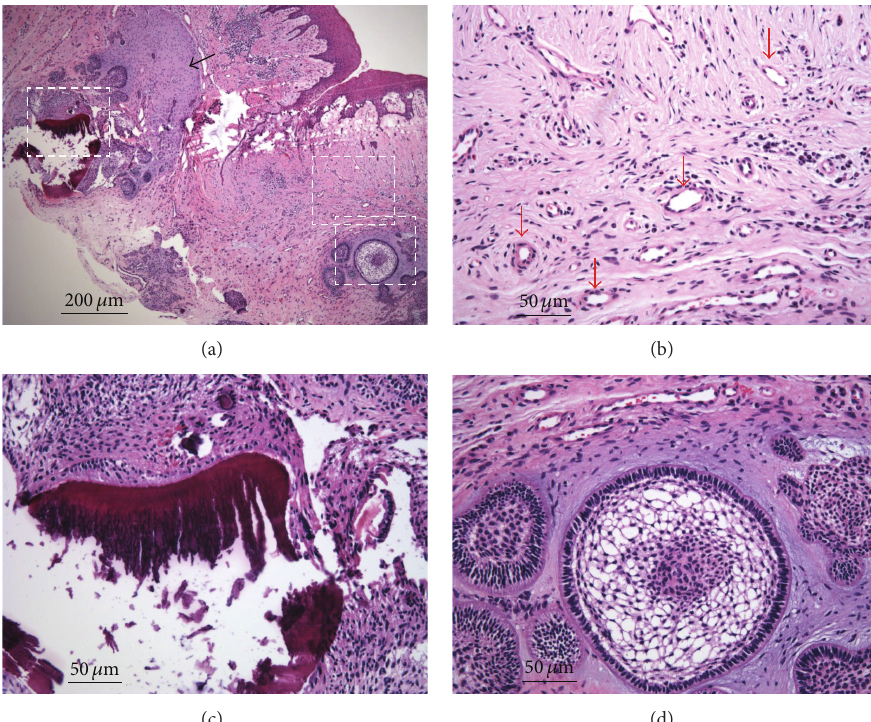
Figure 2: Hematoxylin and eosin staining for the gingival lesion. (a) The black arrow indicates a dental papilla-like tissue. (b) The red arrows denote abundant small blood vessels. (c) A large mineralized matrix appears like enamel or dentin structures. (d) There are several islands of odontogenic epithelium. One of them clearly exhibits enamel organ differentiation. Panels (b), (c), and (d) are magnifications ( × 4) of the white squares of panel (a). Scale bar = 200 𝜇 m for panel (a) and 50 𝜇 m for panels (b), (c), and (d).